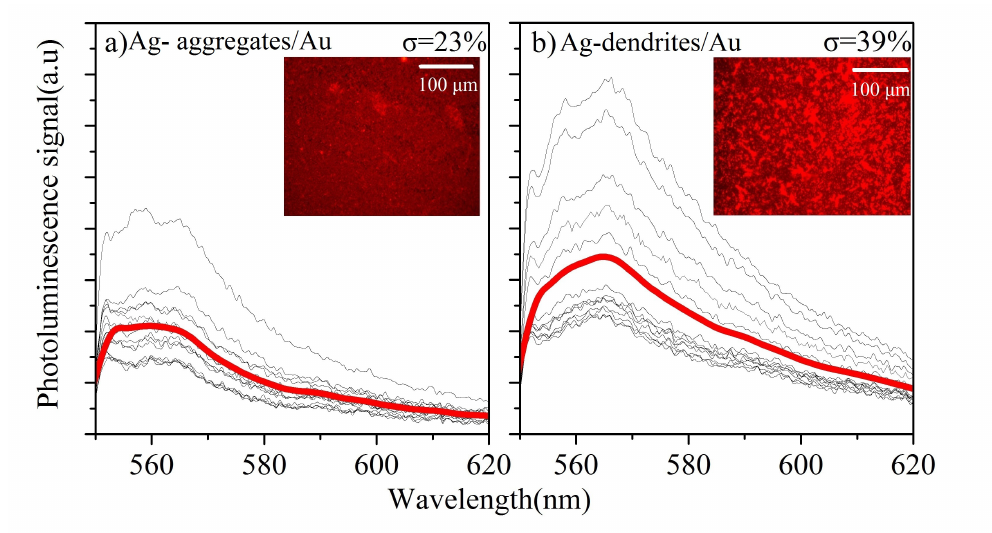
Figure 6. Micro-PL mapping signal comparison of ( a ) Ag-aggregates/Au and ( b ) Ag-dendrites/Au. Each plot shows N = 14 measurements at different points on the sample and the bold line represents the average signal. The relative standard deviation of the PL peak intensity ( σ ) was σ = 23% for Ag- aggregates/Au and σ = 39% for Ag-dendrites/Au. The inset shows typical fluorescence microscope images obtained with a TexasRed dichroic filter (see